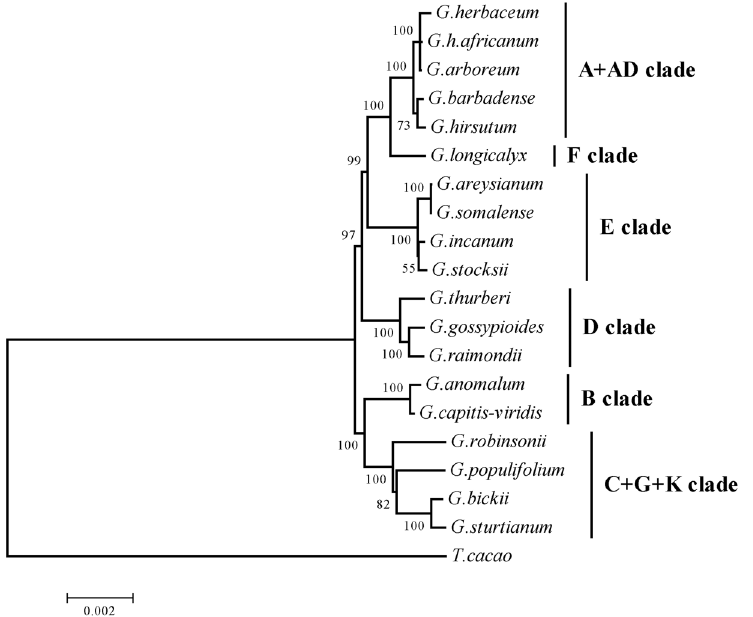
Fig 2. Maximum likelihood (ML) phylogenetic tree of 19 Gossypium species based on several analyses, including whole genome sequences, 78 concatenated chloroplast protein-coding exons sequences and indel-coded data. Theobroma cacao was used as outgroup. Bootstrap values for all major divergences were high ( > 90%) on the corresponding nodes (Bayesian tree is similar, and therefore not